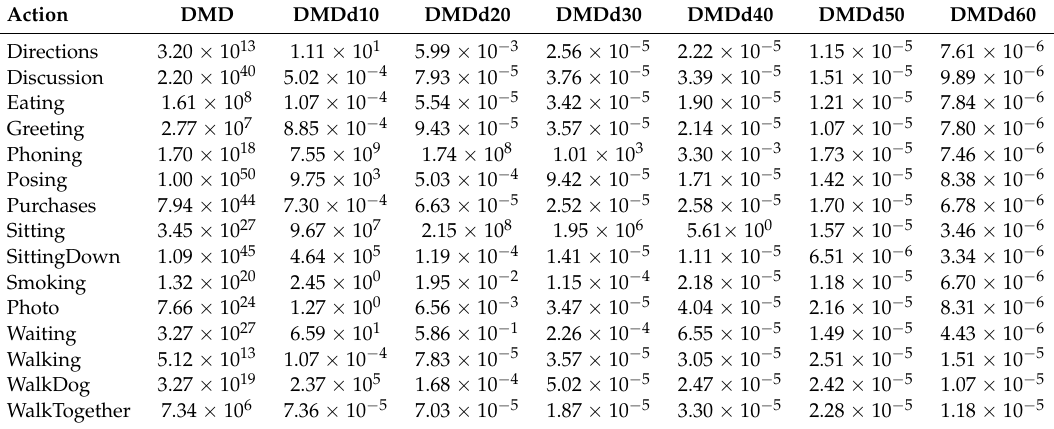
Table 3. Comparison of reconstructions errors using Dynamic Mode Decomposition (DMD) and Dynamic Mode Decomposition with delays for various numbers of delays (10, 20, 30, 40, 50, and 60). The error measure is the mean squared error on the pose sequences of 2s length on the different motion classes of the Human 3.6M dataset for actor #5.